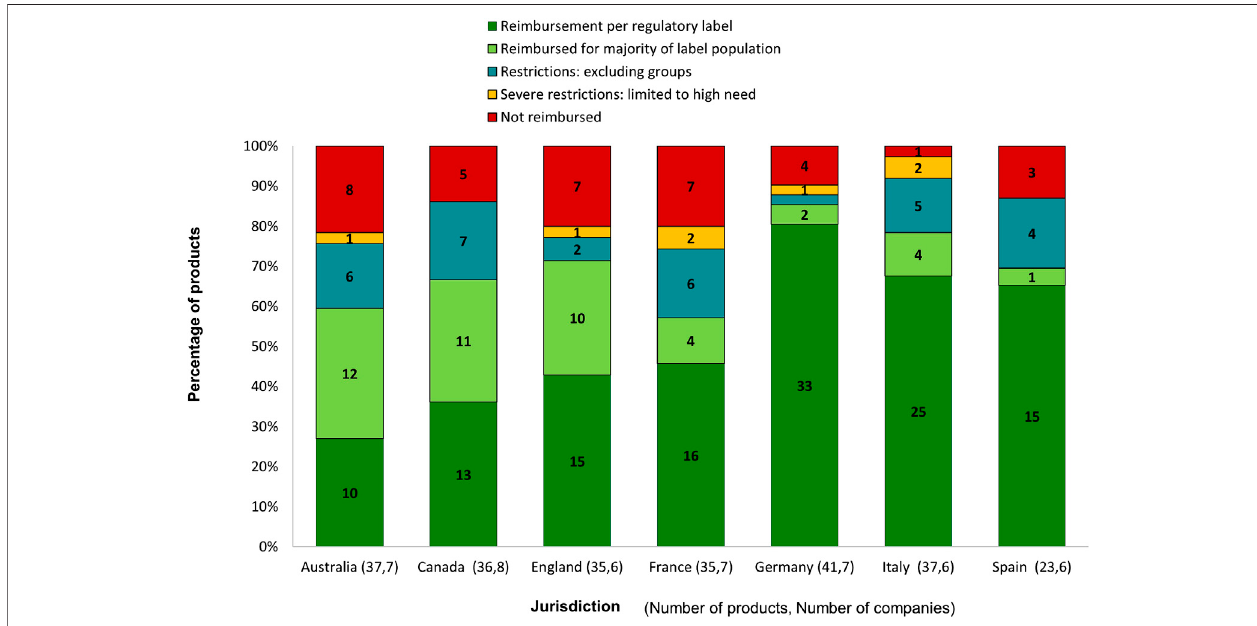
FIGURE 4 | Reimbursement decisions for products provided by participating